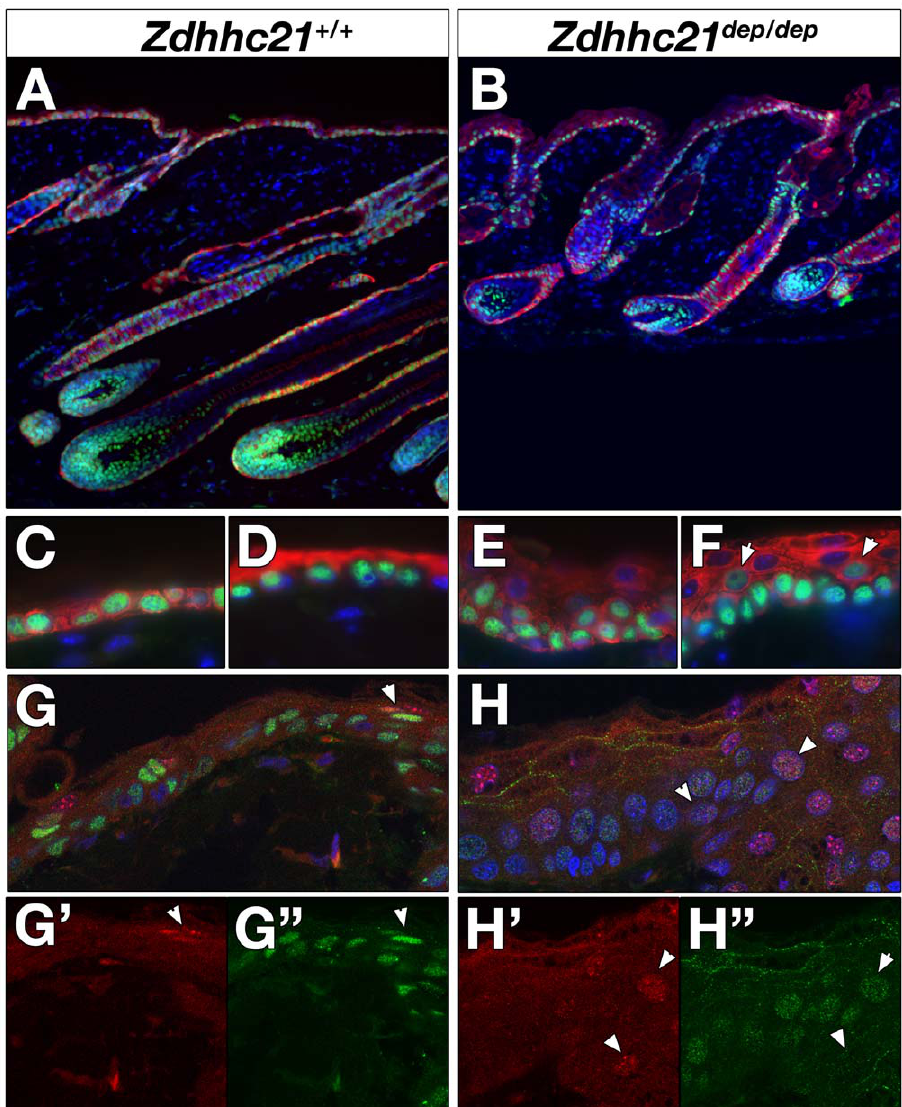
Figure 5. Loss of Zdhhc21 disrupts balance between proliferation and differentiation in anagen interfollicular epidermis. P28 wild type (A,A 9 ,C,D,G,H,K,L) and dep (B,B 9 ,E,F,I,J,M,N) skin. dep mutants show expansion of K5 + (red), p63 + (green) progenitor compartment (A–D). p63 + progenitors (green) are expanded into terminally differentiating K10 + (red) layers of dep IFE (D,F). Expression of transcriptional regulator of differentiation Gata3 in the basal and suprabasal keratinocytes is greatly reduced or absent in dep IFE with a parallel increase in proliferative basal phospho-ERK signals (green; Gata3, red; phospho-p42/44, G,H). (G–H 0 ) single channels of region of interest in merge shown in (G,H).